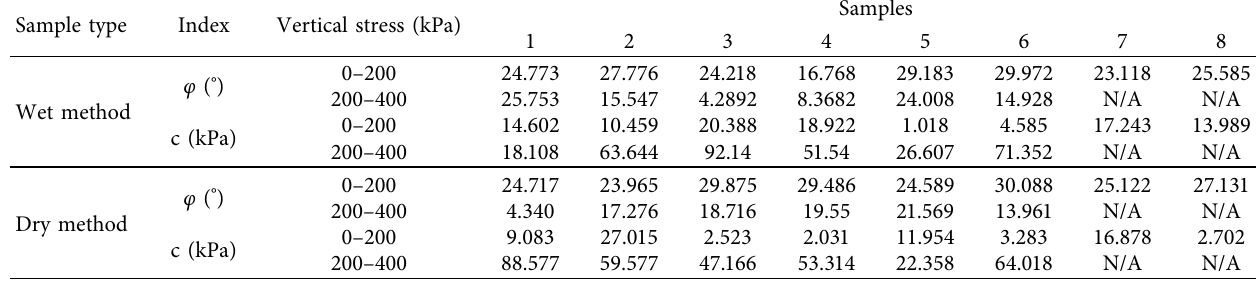
Table 6: Cohesion c and angles of internal friction φ index values of different samples.